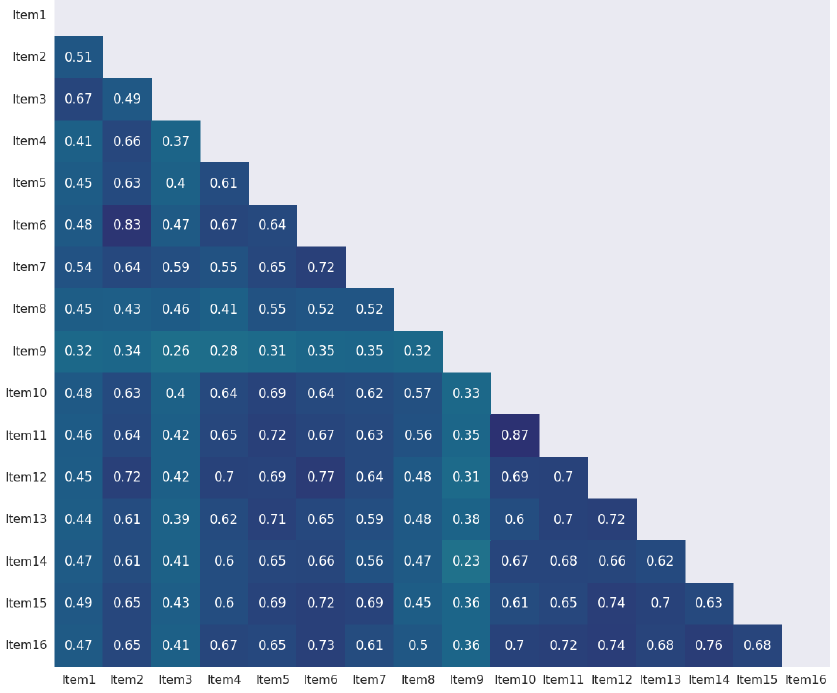
Figure 1. A heatmap showing Pearson correlations between DSES items in Sample 1. Since only the first initial eigenvalue (9.6) was greater than simulated data from parallel analysis (see: Figure 2) only one factor was extracted, which accounted for 57.6% of common variance. As is shown in Table 1, factor loadings ranged from 0.417 to 0.855 with uniqueness from 0.268 to 0.826.